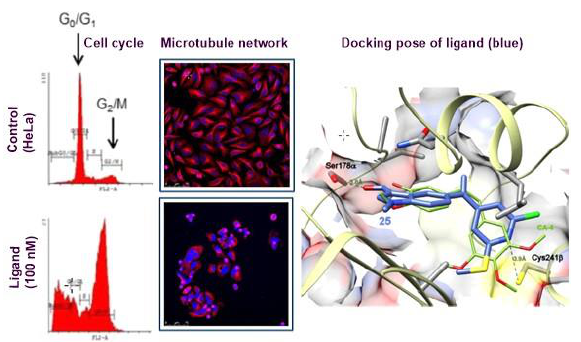
Figure 10. Left: Ligand effects on cell-cycle arrest and microtubule network. Right: Docking pose of one of methylsulfanylpyridine derivatives’ synthesized ligands (blue) superimposed with the X-ray pose of CA-4 (green).